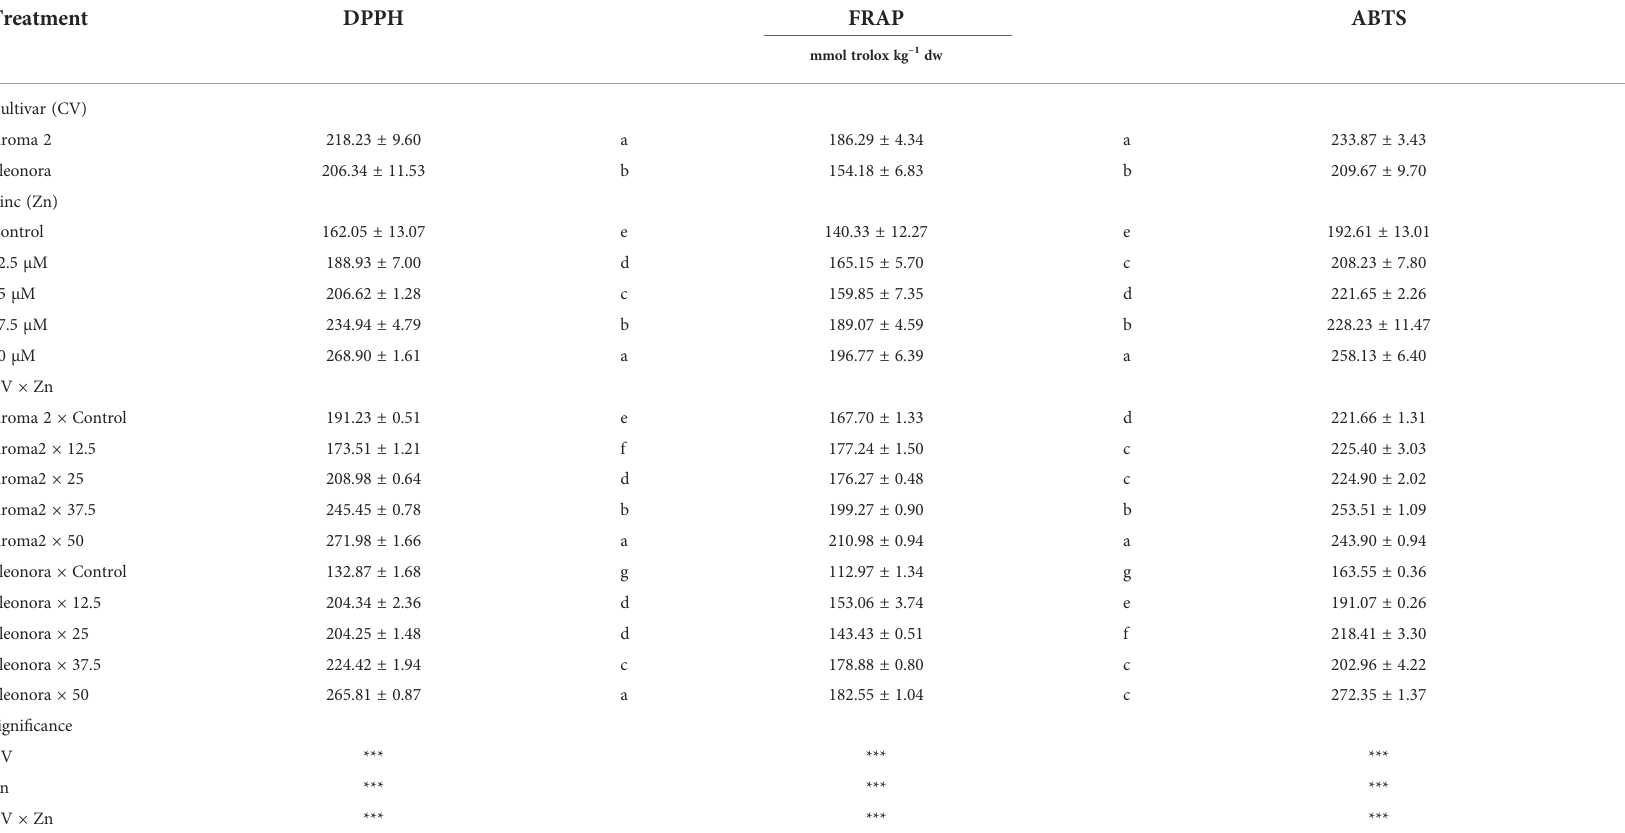
TABLE 4 Analysis of variance and mean comparisons for DPPH, FRAP, and ABTS antioxidant activities of Aroma 2 and Eleonora basil cultivars grown hydroponically under different Zn treatments: 0 = Control; 12.5; 25; 37.5; 50 µmol of Zn]. Treatment